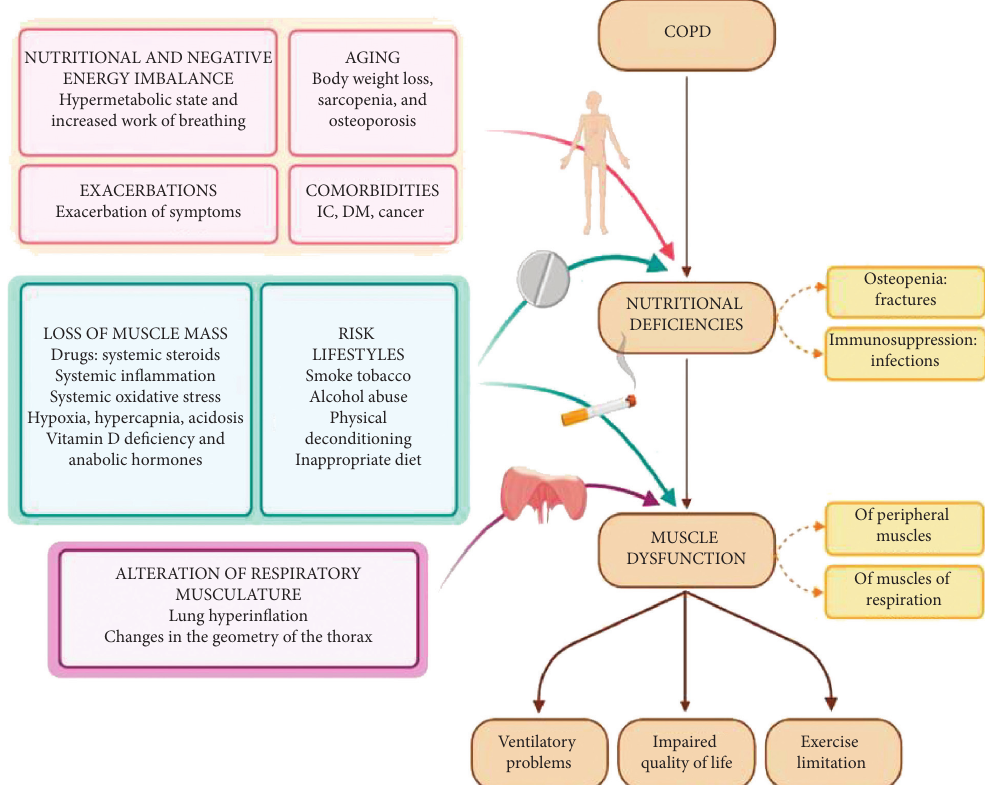
Figure 1: Factors that contribute to the presence of nutritional deficiency and muscle dysfunction in COPD patients (modified from Gea J Sancho-Muñoz A Chalela R Nutritional status and muscle dysfunction in chronic respiratory diseases: stable phase versus acute exac- erbations. J Thorac Dis. 2018; 10 (12): S1332–S1354. DOI:10.21037/jtd.2018.02.66; ∗ figure created on the BioRender